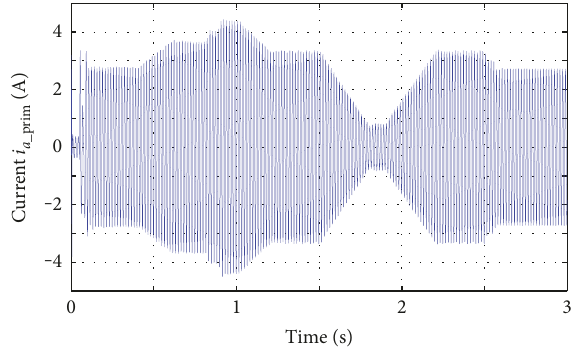
Figure 12: Current increase.